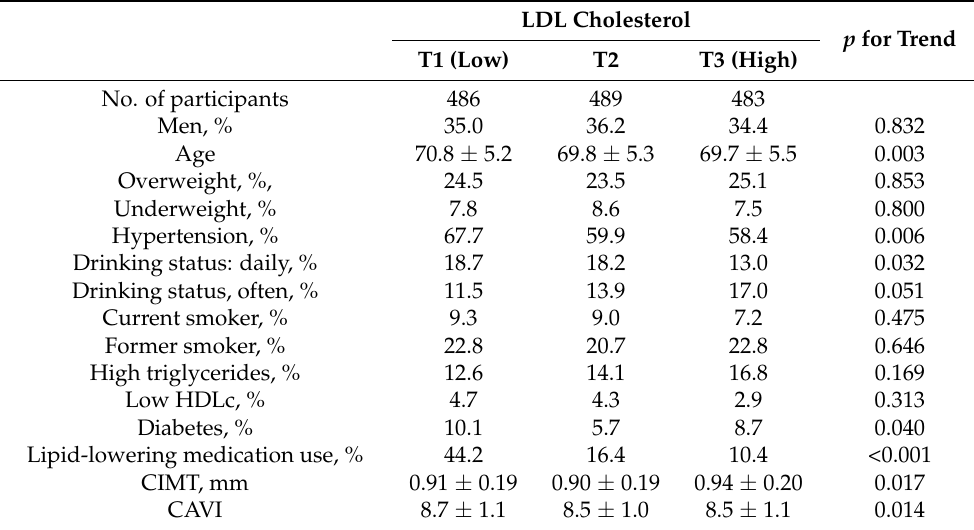
Table 1. Characteristics of study population in relation to LDL cholesterol.